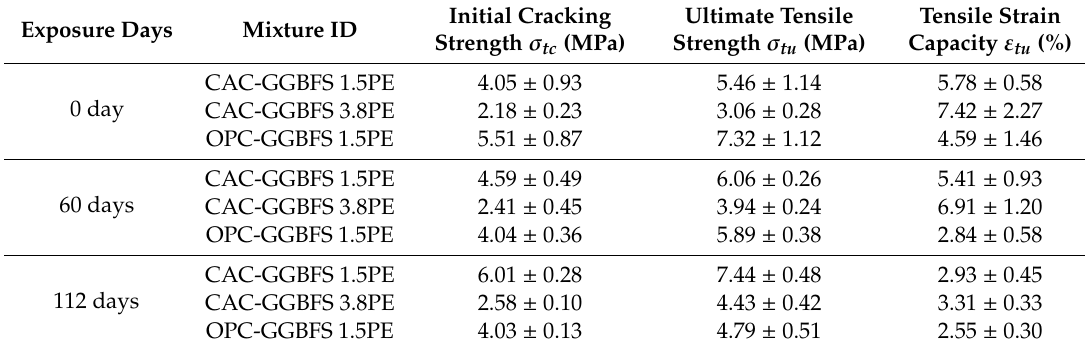
Table 5. Tensile properties of fibre reinforced mortar before and after sulfuric acid exposure. Exposure